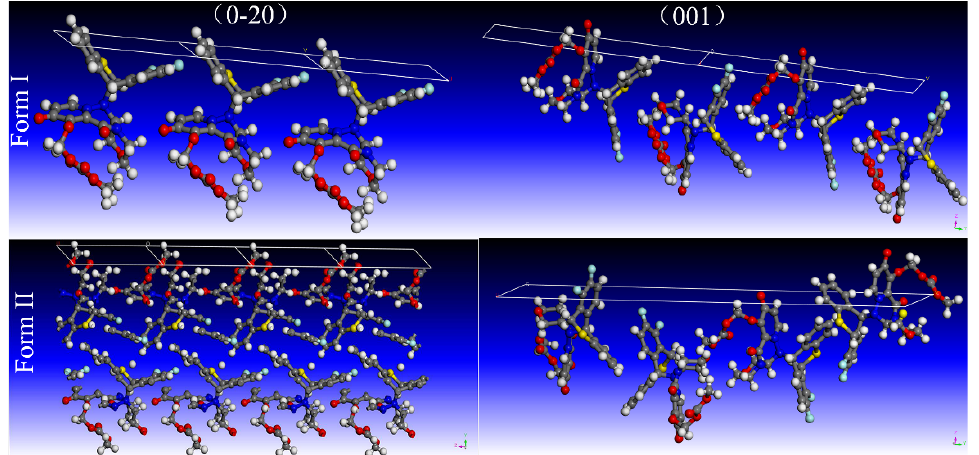
Figure 8. Crystal slices of different facets of BXM Form I and Form II expressing the presence of functional groups. The most dominant facet (0 – 20) is covered by 1 phenyl, and the second dominant facet (001) is covered by 1 carbonyl in Form I. In Form II, the most dominant facet (0 – 20) is covered by 1 methoxyl, and the second dominant facet (001) is covered by 2 fluorines, 2 carbonyl, and 1 methymethyl carbonate chain.